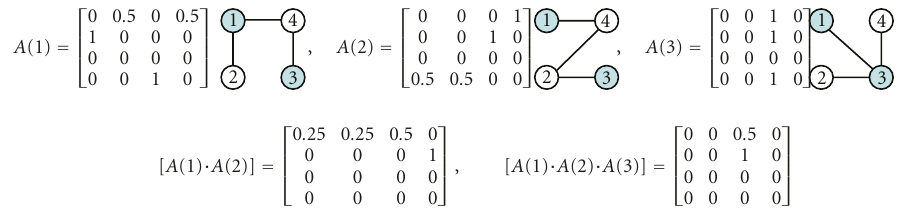
Figure 6: Example evolution of the forwarding matrix for a time-varying